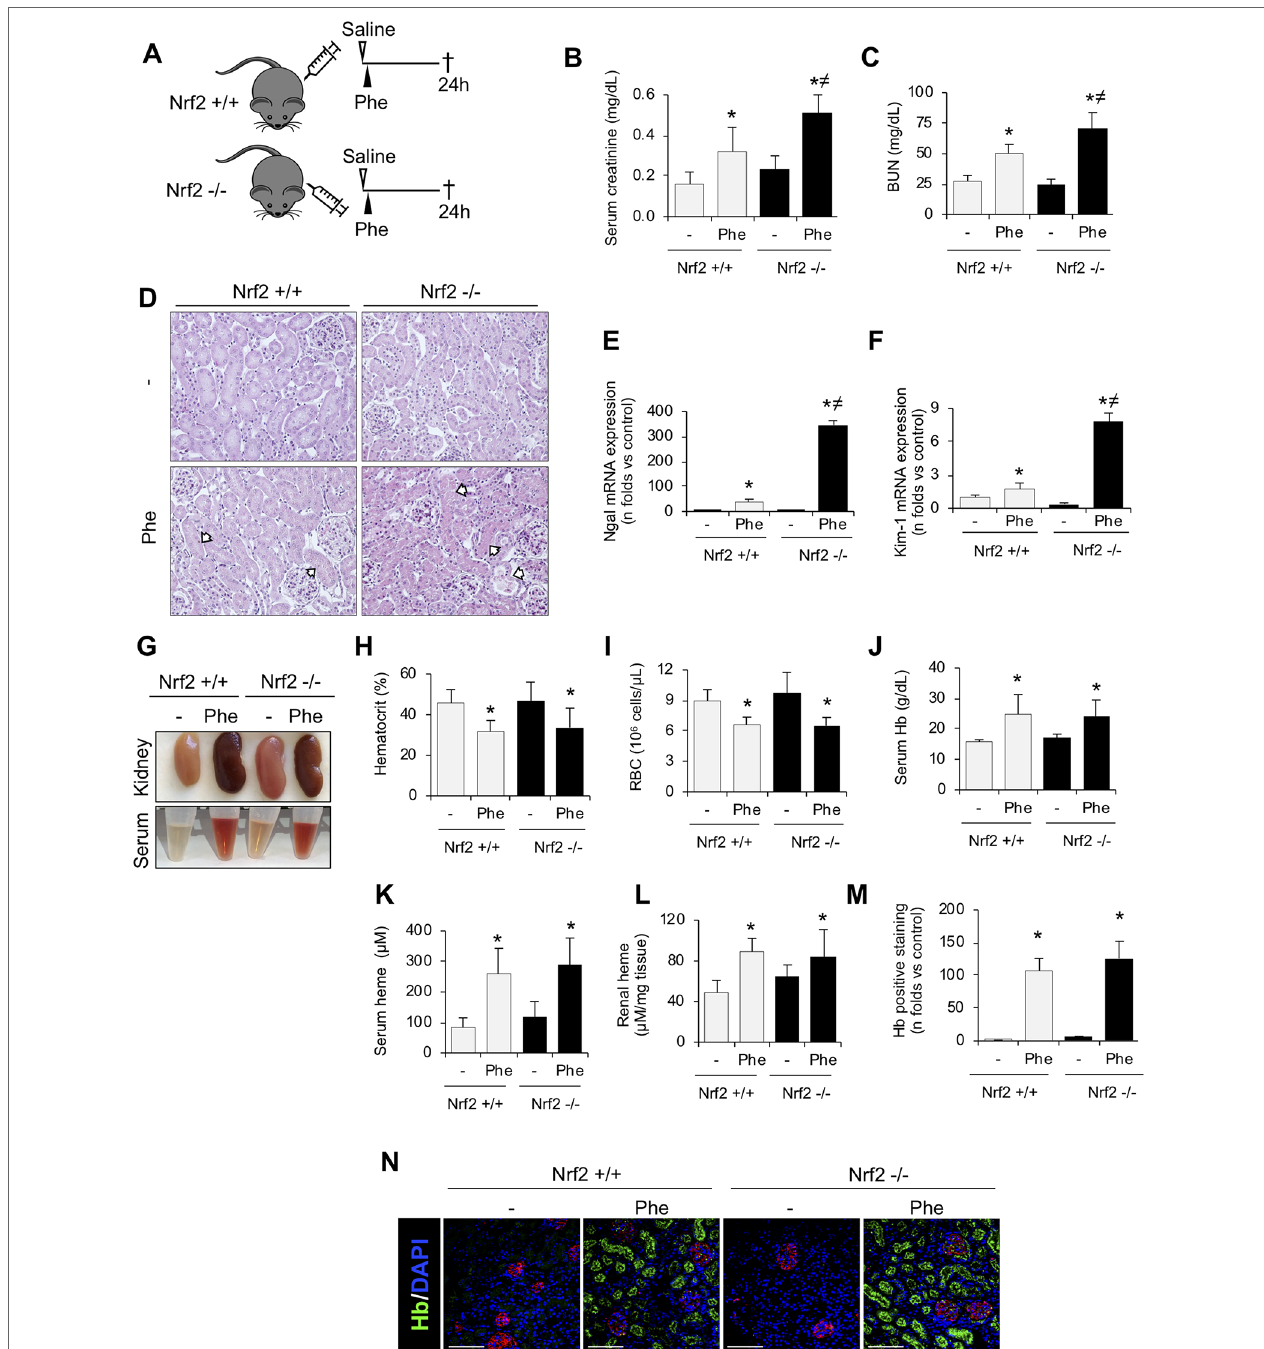
FIGURE 3 | Nrf2 plays a protective role against kidney injury associated with intravascular hemolysis. C57BL/6 (Nrf2+/+) or Nrf2−/− mice (12 weeks old) were i.p. injected with saline (vehicle) or phenylhydrazine (Phe, 2 mg/10 g of body weight) to induce intravascular hemolysis ( n = 8/group). (A) Schematic representation of intravascular hemolysis mouse model. Serum measurement of creatinine (B) and blood urea nitrogen (BUN) (C) . (D) Representative images showing hematoxylin and eosin staining in kidneys from mice with intravascular hemolysis. Arrows indicate signs of acute tubular injury: presence of intratubular debris, pyknotic nuclei from apoptotic cells, tubular epithelial cells into the lumen, and loss of nuclei in the tubular epithelium. Expression of tubular injury biomarkers NGAL (E) and KIM-1 (F) , as determined by real-time RT-qPCR, in kidneys from mice with intravascular hemolysis. (G) Representatives images showing kidneys (upper row) and serum (lower row) after intravascular hemolysis in both Nrf2+/+ and Nrf2−/− mice. Hematocrit (H) , total red blood cell (RBC) counts (I) , serum levels of Hb (J) and heme (K) , and heme concentrations in renal tissue (L) . (M) Semi-quantification of hemoglobin (Hb)-positive staining per renal cross section. (N) Representative images showing Hb (green) accumulation obtained by confocal microscopy. The podocyte marker nephrin (red) was used to delimitate the glomerular area. Nuclei were stained with DAPI (blue); scale bar, 100 μm. Results are expressed as mean ± SE. * p < 0.05 vs Nrf2+/+ control mice, ≠ p < 0.05 vs Nrf2+/+ Phe-injected